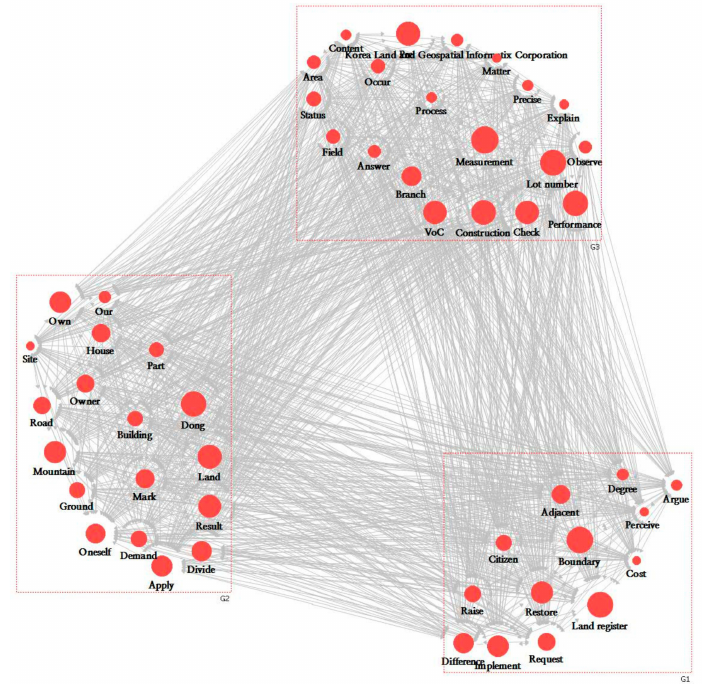
Figure 3. Results of keyword network by